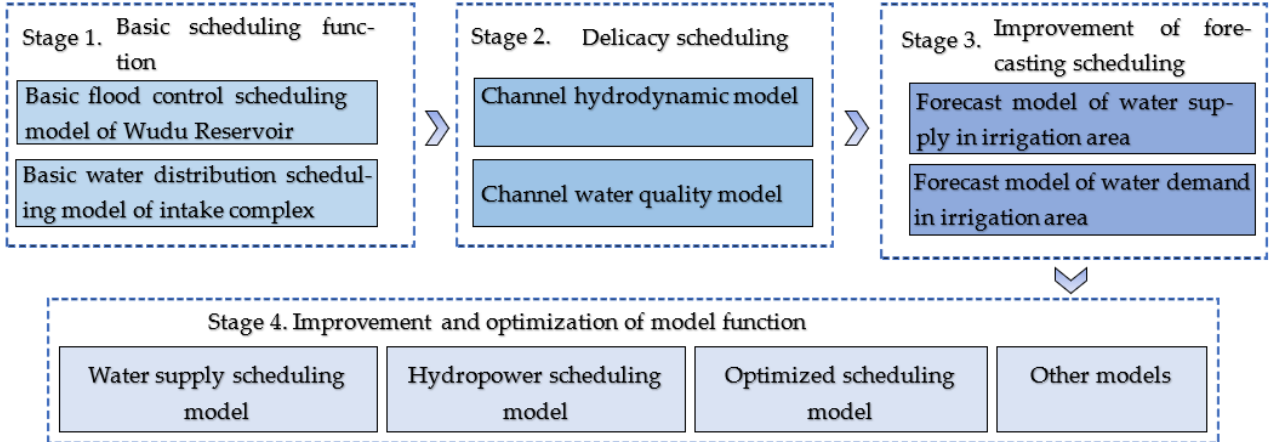
Figure 3. Stage-by-stage development design of model functions in the Wudu diversion and irrigation area.